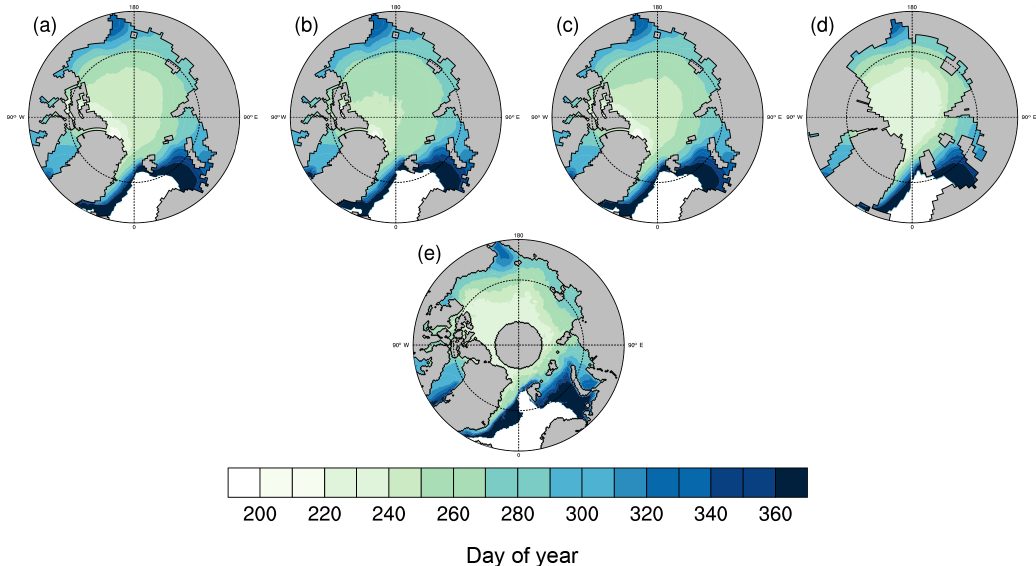
Figure 4. Average freeze onset dates for 1979–2014 for each CESM LE definition using ensemble member 35: (a) congelation ice growth definition, (b) frazil ice growth definition, (c) thermodynamic ice volume tendency definition, (d) surface temperature definition and (e) PMW satellite observations. Plots from ensemble member 34 are very similar and shown in Fig.